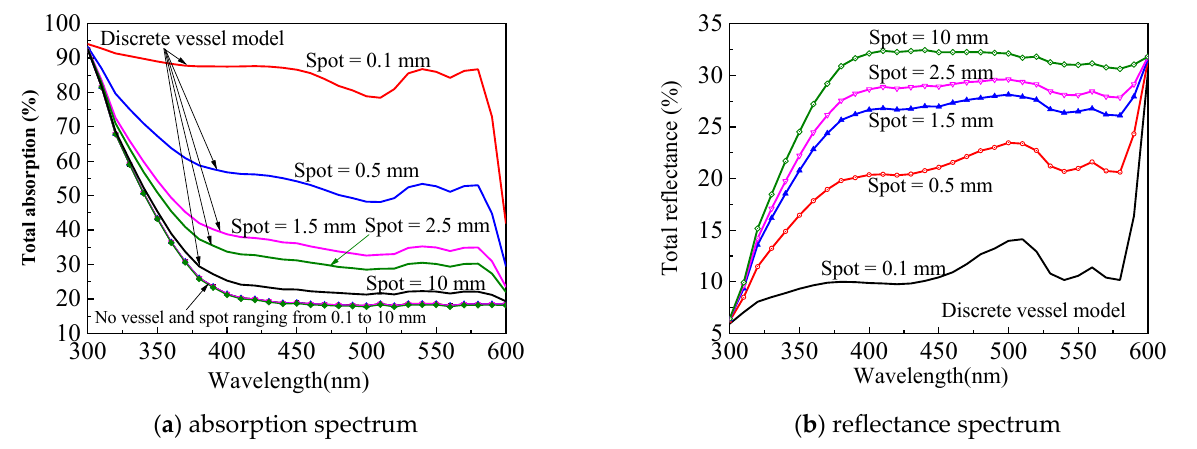
Figure 14. Beam spot-affected spectral signal.